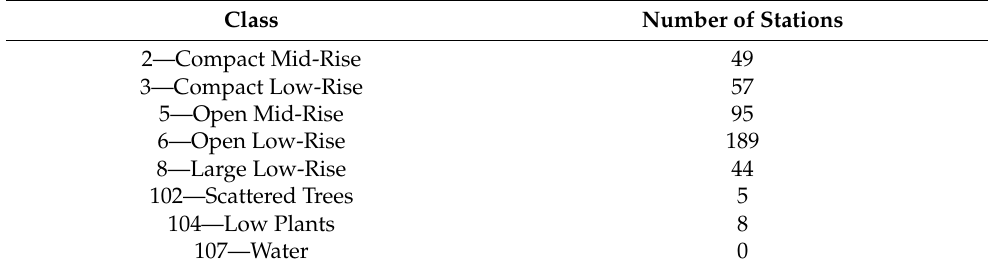
Table 7. Number of air temperature stations per LCZ class.